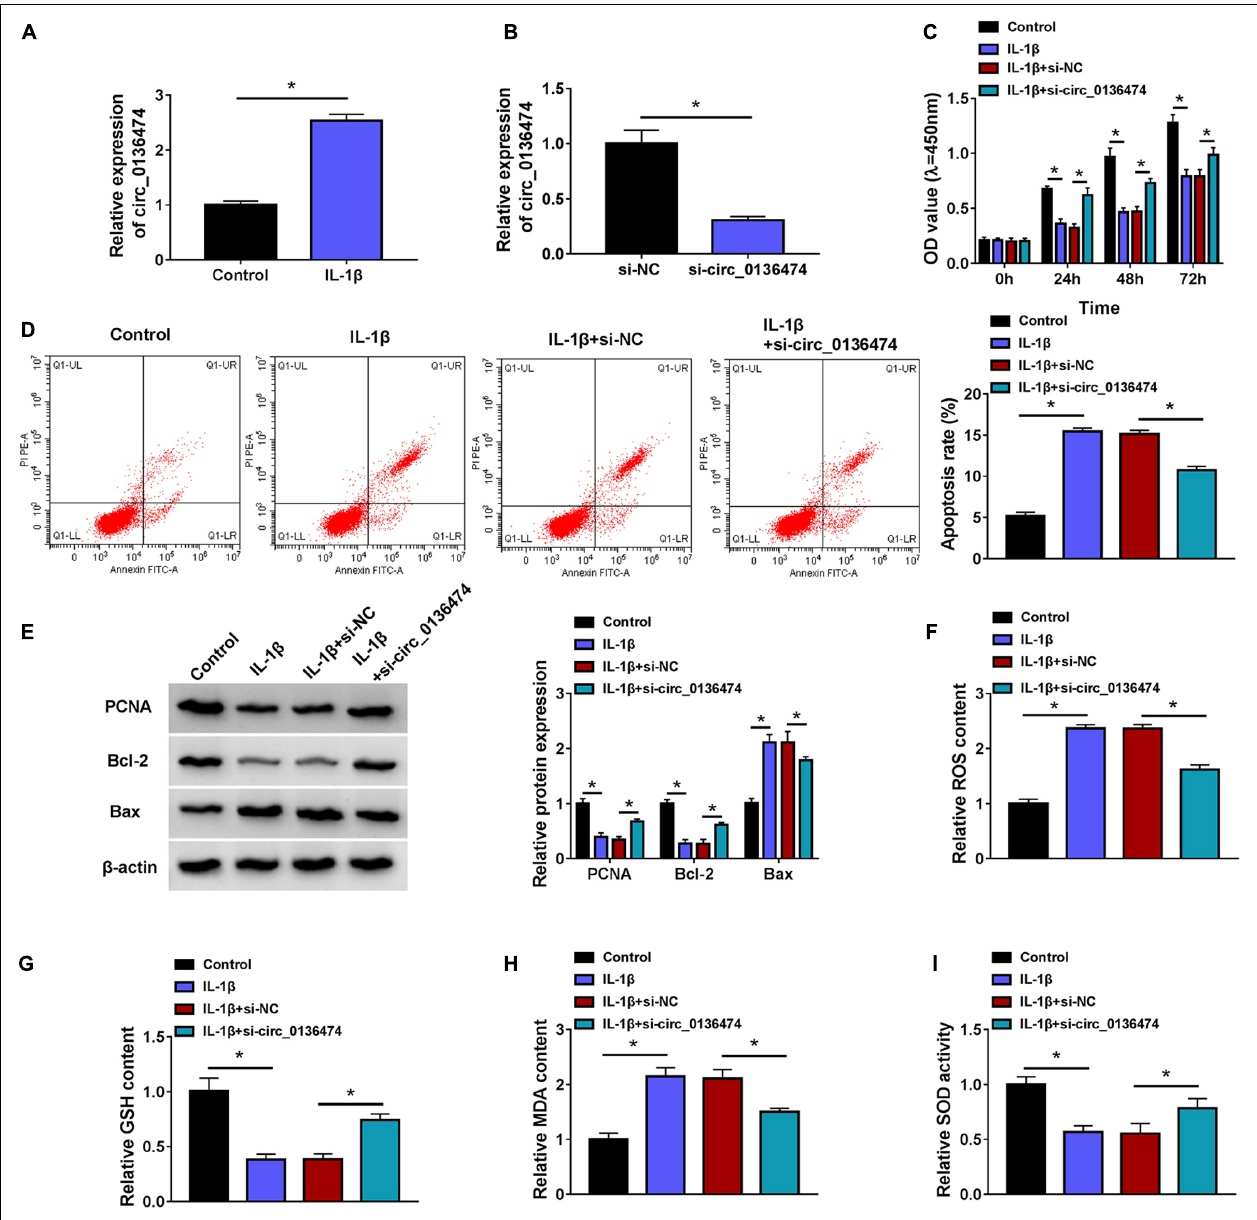
FIGURE 3 | Exhausting circ_0136474 mitigated apoptosis and oxidative stress in IL-1 β -induced chondrocytes. (A) qPCR detected relative expression of circ_0136474 in CHON-001 cells treated with 10 ng/ml of IL-1 β for 24 h. IL-1 β -induced CHON-001 cells were pre-transfected with si-circ_0136474/NC, (B) qPCR detected the relative expression of circ_0136474, (C) CCK-8 monitored the optical density (OD) values of inoculated cells during 72 h, (D) Flow cytometry (FCM) tested the apoptosis rate (%), (E) Western blotting examined the relative protein expression of proliferating cell nuclear antigen (PCNA), B cell lymphoma (Bcl)-2, and Bcl-2-associated X protein (Bax), and (F–I) special assay kits determined the levels of reactive oxygen species (ROS), reduced glutathione (GSH), malondialdehyde (MDA), and superoxide dismutase (SOD). * P < 0.05 was determined by unpaired t -test, ordinary one-way ANOVA, or two-way